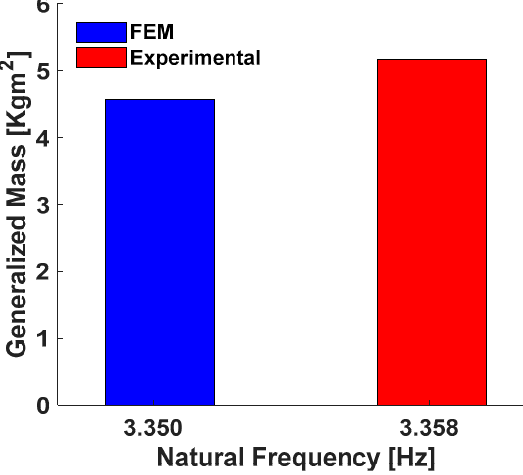
Figure 25. Frequency swept close to the resonance frequency ( f = 3.358 Hz).